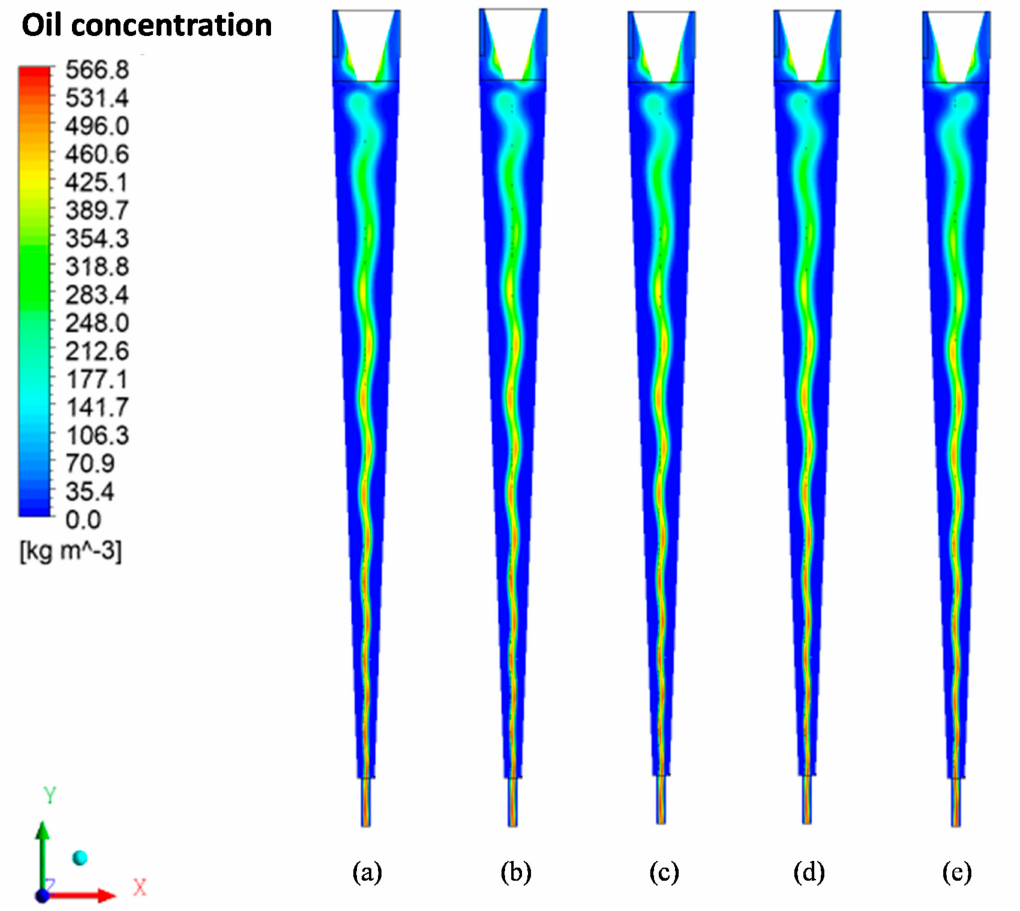
Figure 10. Oil concentration fields for different values of the membrane rejection coefficient: ( a ) R = 0.96; ( b ) R = 0.97; ( c ) R = 0.98; ( d ) R = 0.99, and ( e ) R = 1.00, with δ p = 7.82 × 10 − 2